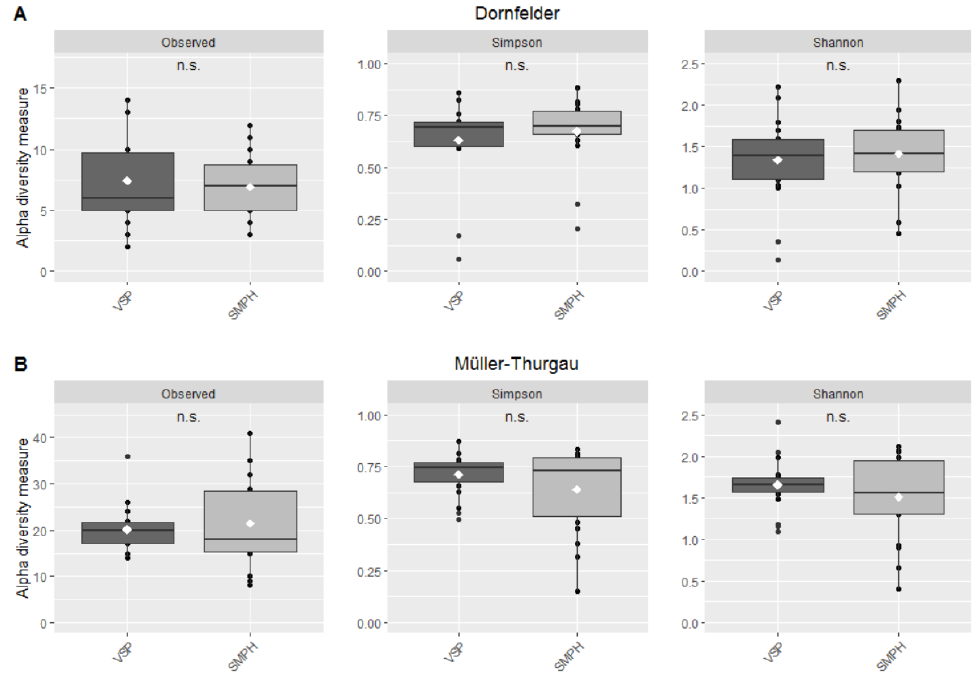
Figure 5. Fungal alpha diversity, i.e., observed OTUs, Simpson and Shannon indices in the grapevine trunk as a function of the training system (VSP and SMPH), for samples collected in the ( A ) ‘Dornfelder’ and ( B ) ‘Müller-Thurgau’ vineyard s. Asterisks indicate significant differences in fungal diversity between the pruning systems according to Wilcoxon rank-sum test (n.s. = not significant).